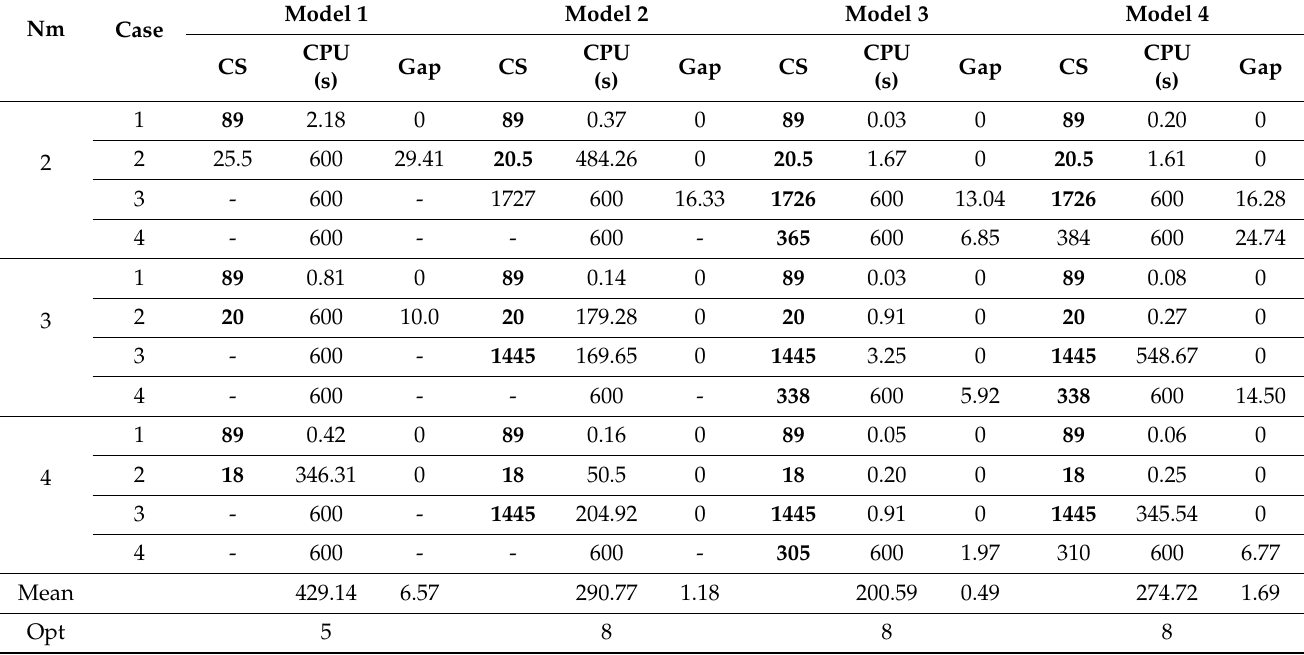
Table 3. Comparisons of computational